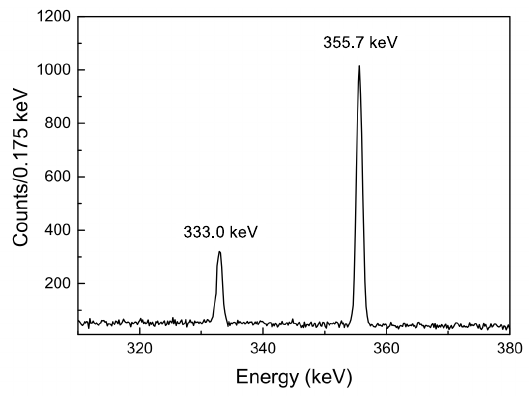
Figure 3. Experiment setup of 197 Au( γ , n) reaction measurement Figure 1. Scheme of detector setup